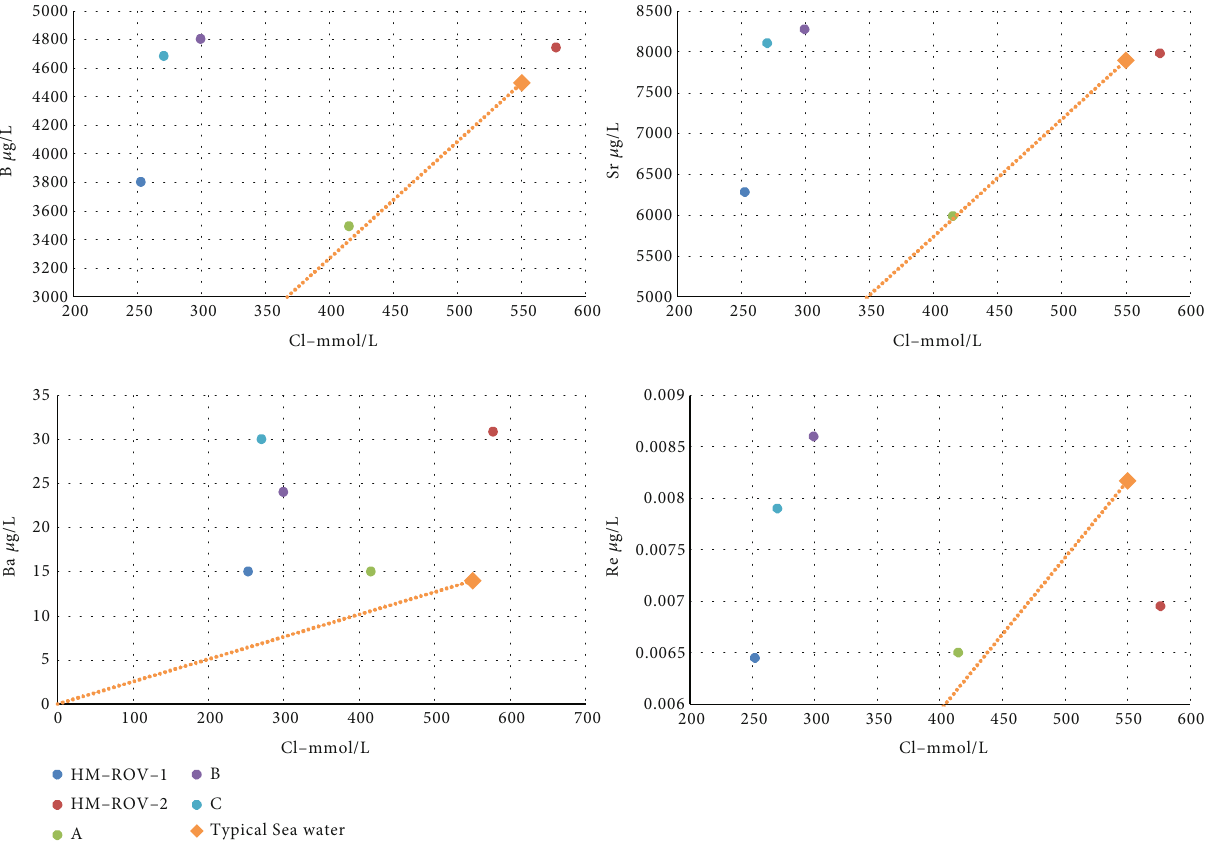
Figure 5: Comparison of the concentrations of B, Sr, Ba, and Re with the Cl - concentration, separately. The dotted line represents the connection between the typical seawater point and the point (0,